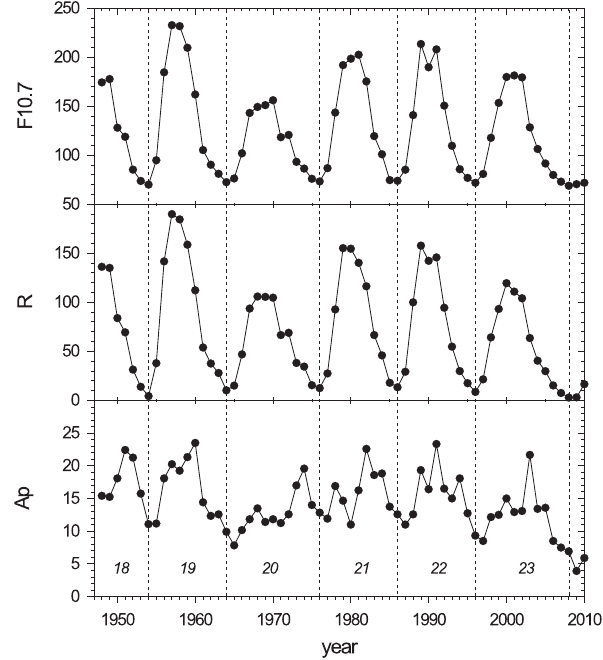
Fig. 2. Long-term variation of solar 10.7cm radio flux F10.7, solar sunspot number R , and geomagnetic Ap value. The vertical dashed lines mark the boundaries of the different solar cycles.